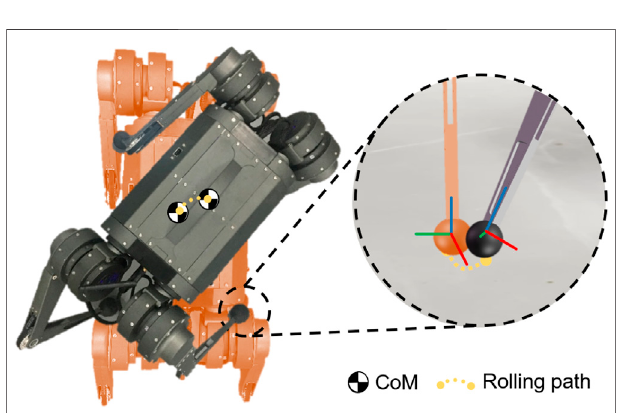
FIGURE2| Theillustrationofasmall-scalequadrupedrobotspinningby rolling the spherical foot end effector on the ground.